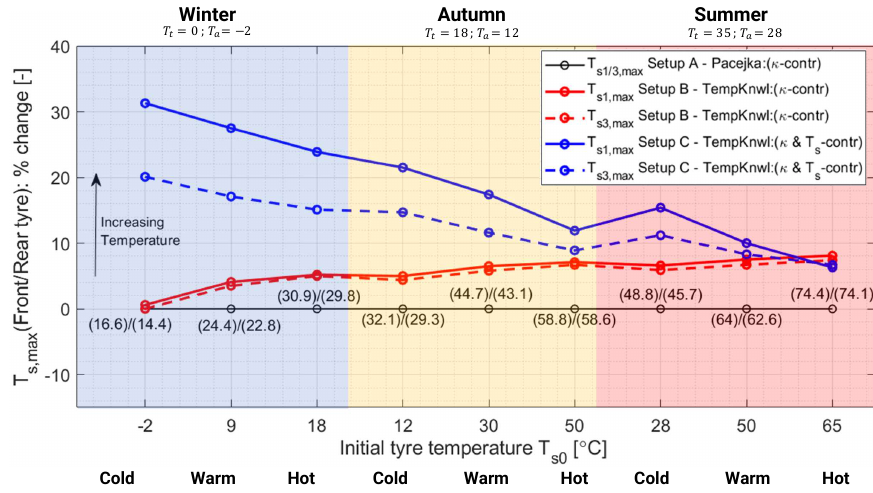
Figure 25. Percentage changes in maximum front and rear tyre tread temperature ( T s 1/3, max ) relative to Setup A starting at 70 m/s for tests 10–18, as shown in Figure 20. The absolute value of maximum temperature for Setup A is stated below each data point ( Front ) / ( Rear )